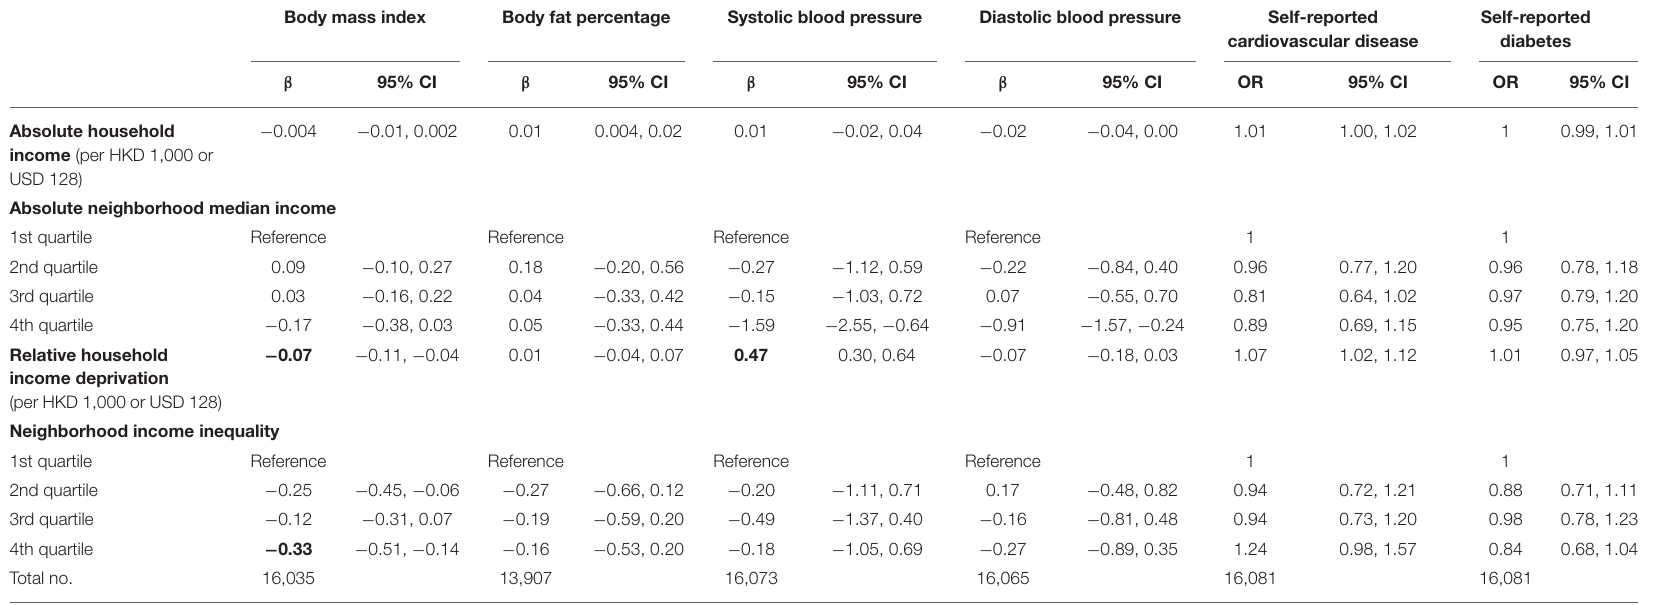
TABLE 2 | Adjusted † association of absolute household income, absolute neighborhood median income, relative household income deprivation, and neighborhood income inequality with cardiovascular disease (CVD) risk factors [body mass index (BMI), body fat percentage, and systolic and diastolic blood pressure] as well as self-reported CVD and diabetes for 17,607 Hong Kong Chinese adults from Hong Kong’s FAMILY Cohort.